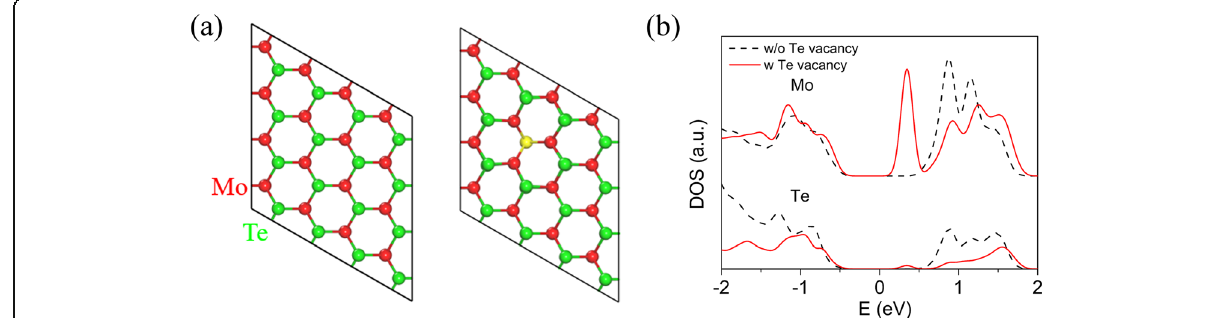
Fig. 7 Te vacancy in MoTe 2 . a 4 × 4 ML MoTe 2 supercells in an ideal phase and with a Te vacancy. The vacancy site is marked in yellow. b Partial density of states (PDOS) of Mo site adjacent to Te vacancy and nearest Te site to a Te vacancy in ML MoTe 2 (red solid), compared to the PDOS in an ideal ML (black dashed)